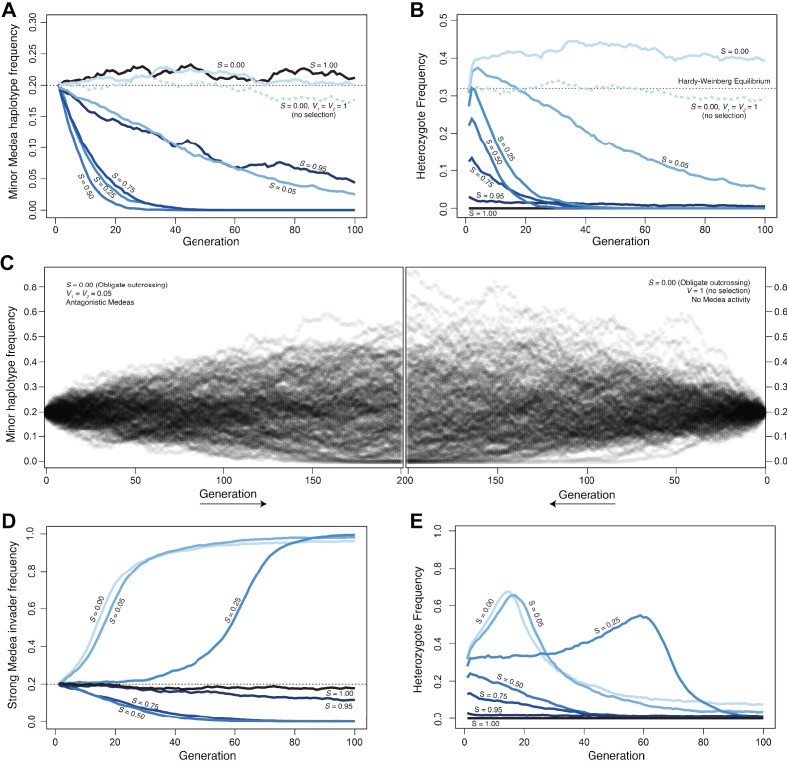
Antagonistic Medeas are subject to drift, genic selection, or positive frequency-dependent selection, depending on the selfing rate.A–C show simulations of antagonistic Medea elements with equal penetrance (0.95), D and E show antagonistic elements with unequal penetrances. (A) At a locus with two haplotypes, each containing Medea elements, allele frequencies change over time as a function of selfing rate (S). At intermediate selfing rates, positive frequency-dependent selection acts to remove the rarer haplotype from the population. This effect is explained by the disproportionate impact of segregation in heterozygous selfers on the rarer haplotype. Heterozygous selfers kill each haplotype in equal proportions (¼ of progeny are homozygous for each haplotype), while outcrossers kill each as a function of their population frequency; the result is that the rare allele suffers more from heterozygote selfing. Intermediate levels of outcrossing result in the highest frequency of heterozygous selfer and so the most efficient selection against the rare allele. Under complete selfing (S = 1), there are no heterozygotes and Medeas have no effect. Under obligate outcrossing, the haplotypes are subject to drift and show similar dynamics to obligate selfers or outcrossers without Medeas. The pattern in obligate outcrossers reflects the maternal-zygotic interaction character of the Medeas. While the Medeas kill homozygotes, generating overdominance and heterozygote excess, this occurs only in heterozygous mothers. The fitness cost to these mothers represents underdominance, favoring homozygotes, and the over- and under-dominance balance each other. This figure shows the results of representative simulations with fixed population size of 20,000 breeding individuals, initial frequencies 0.2 and 0.8, and 95% penetrance of each of the two Medeas. (B). Heterozygote frequencies (from the simulations shown in A) vary over the simulations. Obligate outcrossers maintain substantially elevated heterozygote frequencies. (C) Surprisingly, despite the strong selection against homozygotes and the elevated frequency of heterozygotes in obligate outcrossers, allele frequencies evolve with drift-like dynamics. Results of 200 simulations are shown, each with a fixed population size of 1000 breeding individuals and initial minor allele frequency of 0.2. The left panel illustrates the spread of allele frequencies across simulations in the case of antagonistic Medeas, and the right shows the results with no Medeas. In both cases, frequencies drift and some populations lose the lower-frequency allele. After 200 generations, the allele frequency variances are not different between the two cases (Levene’s test, p=0.13). (D) When a strong Medea element (penetrance 0.95) invades a population carrying a weaker Medea (penetrance 0.6), its ability to displace the weak Medea depends on the selfing rate (S). At low selfing rates, genic selection favoring the strong Medea drives it to high frequency. At intermediate and high selfing rates, positive frequency-dependent selection favors the weaker resident Medea, and the strong haplotype is removed from the population. The figure shows the results of representative simulations with fixed population size of 20,000 breeding individuals, initial frequencies 0.2 and 0.8, and penetrances chosen to represent those of the C. tropicalis JU1373 haplotype (0.95) and NIC58 haplotype (0.6). (E) Heterozygote frequencies (from the simulations in D) evolve, with heterozygosities transiently elevated above 0.5 during sweeps. Source code is available from github.